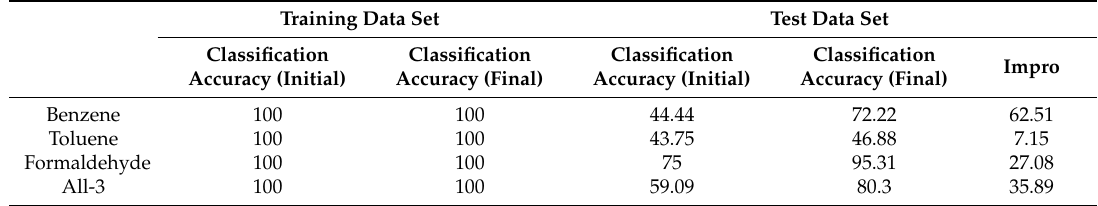
Table 7. Classification accuracy of M-training with 75%-unlabeled rate (%).